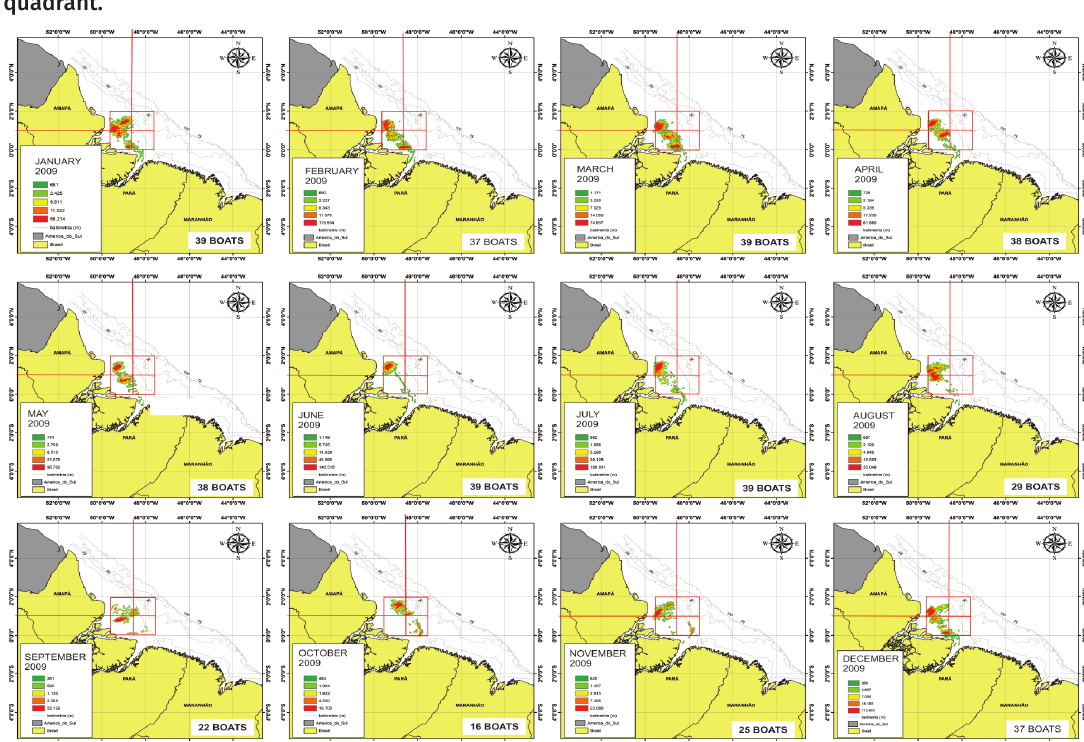
Figure 8. Relative density of fishing activity during the months of 2009 and fishing fleet dynamics divided by